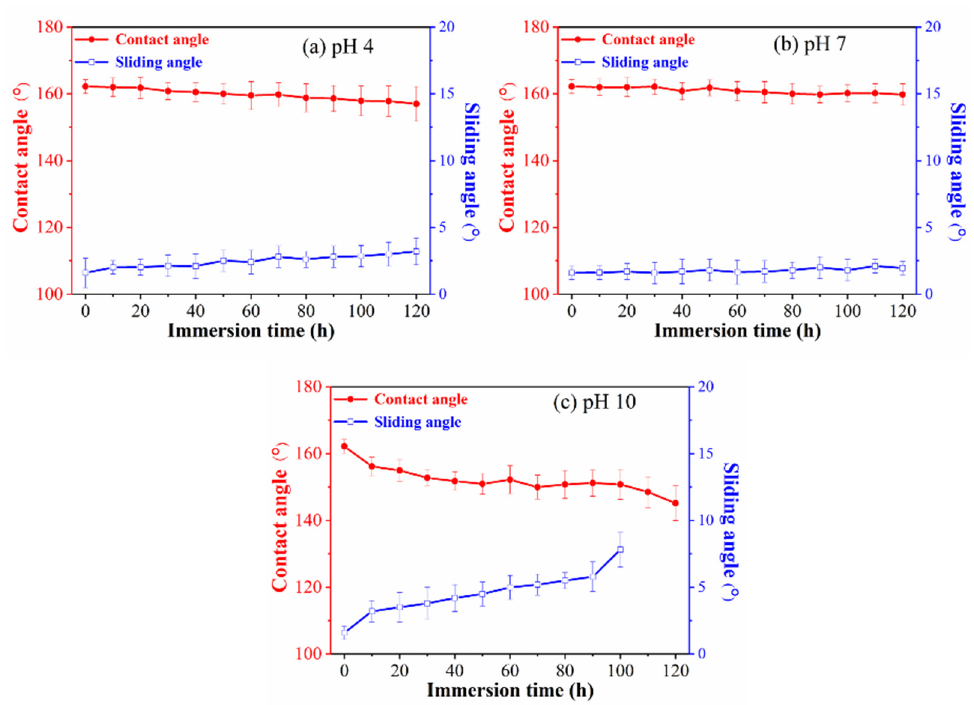
Figure 6. Changes CA and the SA of the superhydrophobic surfaces as a function of immersion time in aqueous solutions at pHs ( a ) 4.0, ( b ) 7.0, and ( c ) 10.0, measured at five different points on the same samples. The error bars for each plot indicate the maximum and minimum water contact angles.